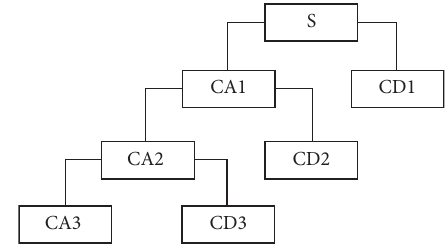
Figure 2: Signal three-level wavelet decomposition